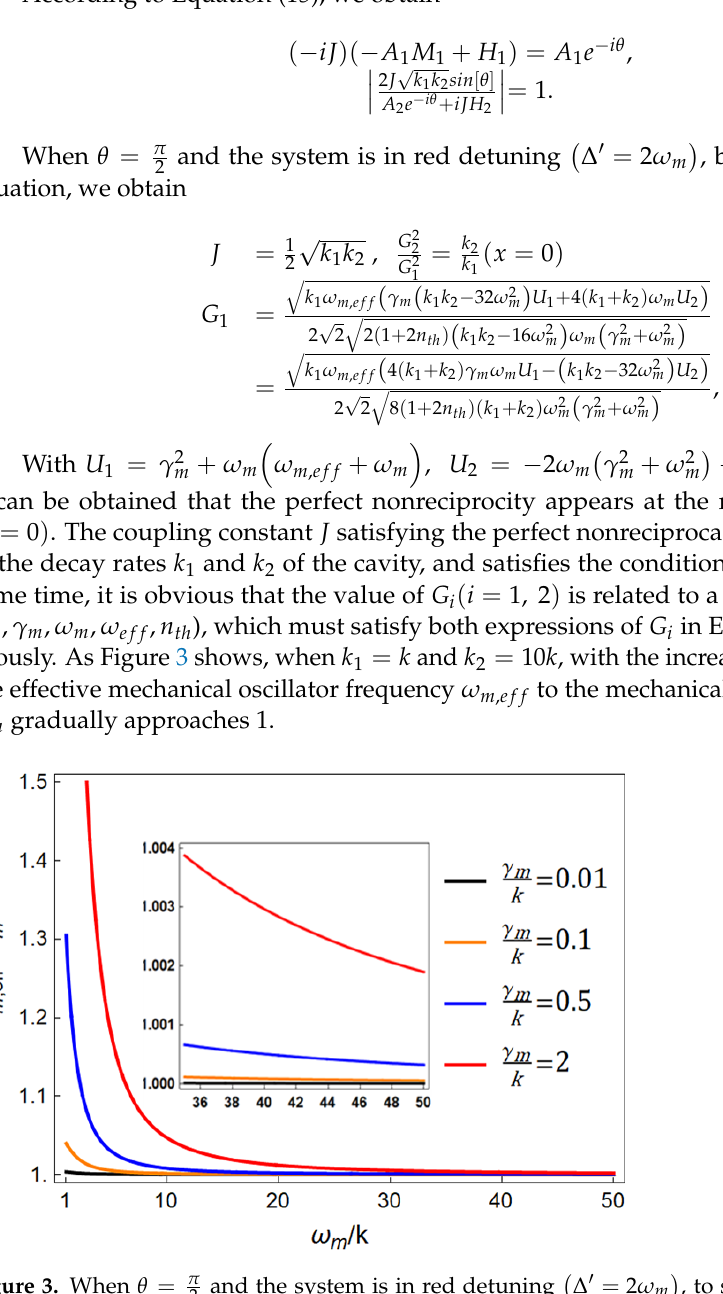
tems with quadratic coupling is related to (cid:1866) (cid:3047)(cid:3035) , and the value of (cid:1866) (cid:3047)(cid:3035) can be controlled by temperature (cid:1846) , so the (cid:1833) (cid:3036) can achieve perfect nonreciprocity at different values by con ‐ trolling temperature (cid:1846) . Under the above conditions, the relationship between transmis ‐ sion amplitudes ( (cid:1846) (cid:2869)(cid:2870) and (cid:1846) (cid:2870)(cid:2869) ) and normalized detuning (cid:3051) (cid:3038) at different (cid:3082) (cid:3288) (cid:3038) is shown in Figure 4, in which the other parameters are taken as (cid:1863) (cid:2869) (cid:3404) (cid:1863), (cid:1863) (cid:2870) (cid:3404) 10(cid:1863), (cid:2033) (cid:3040) (cid:3404) 40(cid:1863), (cid:2033) (cid:3040),(cid:3032)(cid:3033)(cid:3033) (cid:3404) (cid:2033) (cid:3040) and the values of (cid:3082) (cid:3288) (cid:3038) are 0.01, 0.1, 0.5 and 2, in turn. Under the conditions that (cid:1863) (cid:2869) and (cid:1863) (cid:2870) are fixed, and (cid:1836) is also fixed, as (cid:2011) (cid:3040) takes different values, the values of (cid:1833) (cid:2869) and (cid:1833) (cid:2870) will change, but (cid:1833) (cid:2870) (cid:3404) √10(cid:1833) (cid:2869) is always true. It can be seen from Figure 4 that when (cid:3082) (cid:3288) (cid:3038) is relatively small, the spectral line width of transmission amplitude (cid:1846) (cid:2870)(cid:2869) is propor ‐ tional to the damping rate of the mechanical oscillator (cid:4666)(cid:4574) (cid:2033) (cid:3040) ∝ (cid:2011) (cid:3040) (cid:4667) and perfect nonreci ‐ procity can be achieved even when (cid:2011) (cid:3040) is very small. With the increase in (cid:2011) (cid:3040) , it leads to the increase in (cid:1833) (cid:3036) , and the effective optomechanical coupling constant (cid:1833) (cid:3036) begins to play a major role in the signal transmission process, and the range of nonreciprocity increases accordingly.